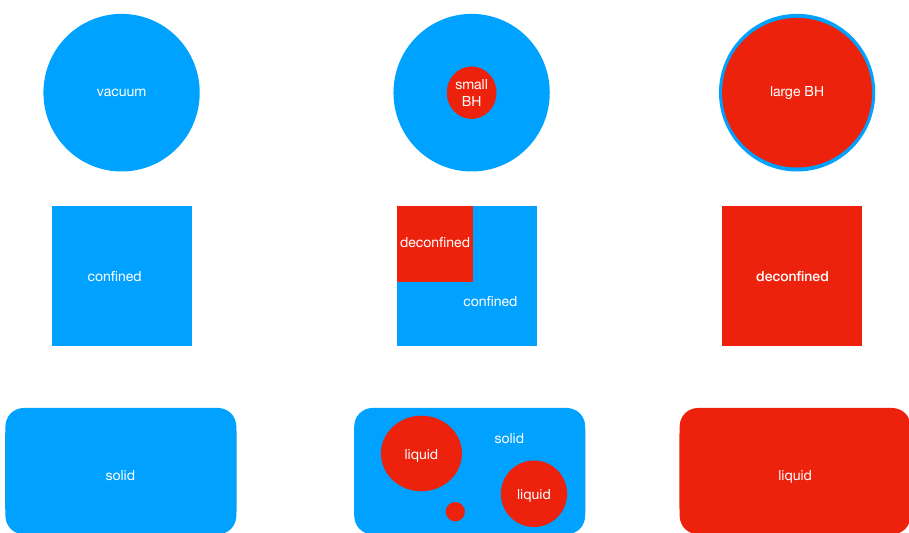
Figure 3. Analogy between three phases in string theory in AdS space (top), Yang-Mills theory (middle) and water (bottom). Each column represent a different phase. The two-phase coexistence is shown in the center column. The two-phase coexistence in color space can take place even when the order of phase transition is not one. As explicit examples, see ref.